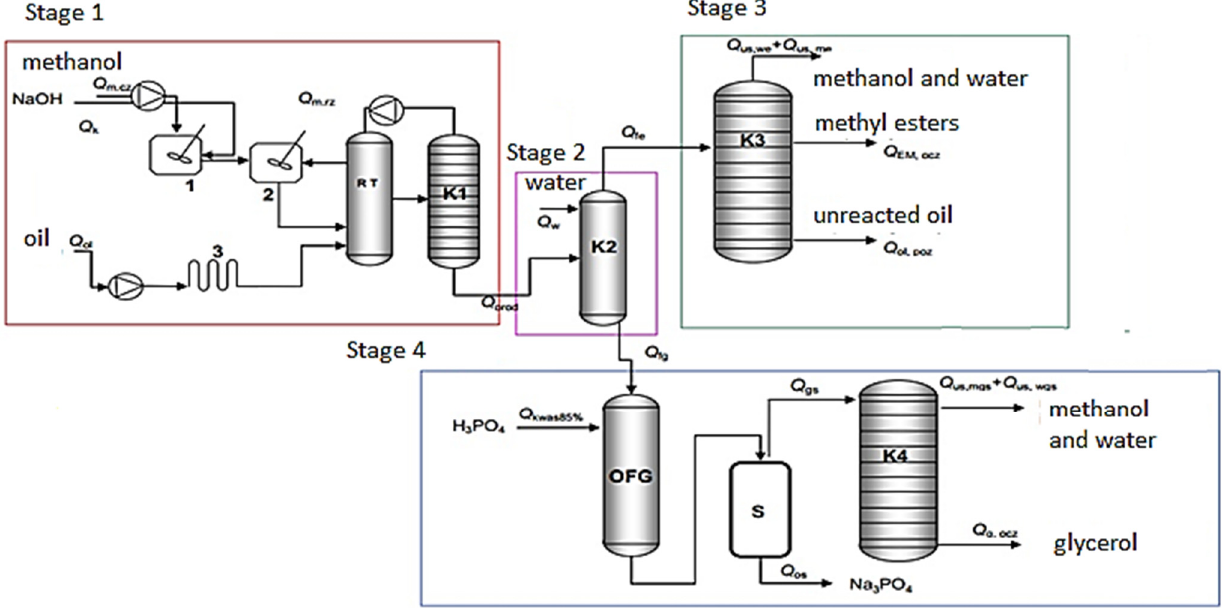
Figure 1. Diagram of biodiesel production by transesterification with the use of a basic catalyst in a flow system. Source: own study.